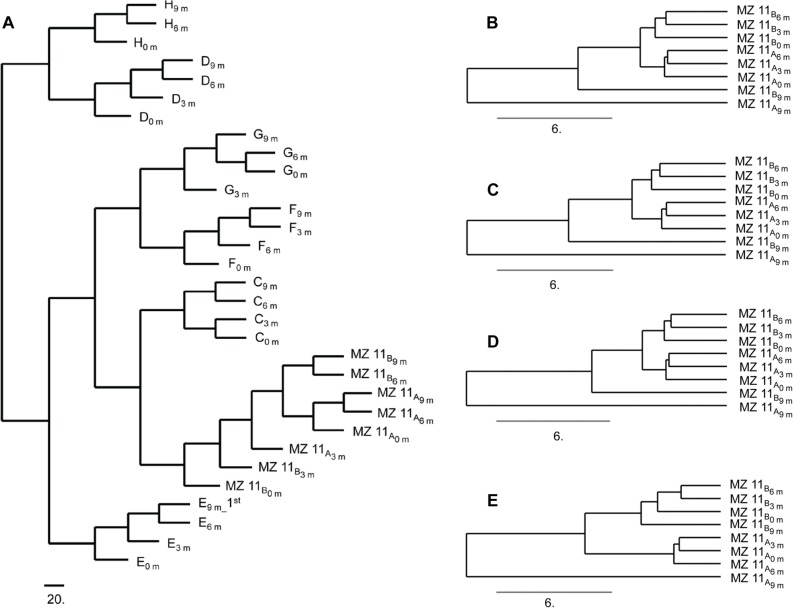
Similarity between individuals based on M-value.(A) Hierarchical clustering on 369,187 CpG sites from 31 whole blood samples collected from 8 individuals at 4 (0, 3, 6, and 9 months) or 3 (0, 6, and 9 months) time points. (B-D) Hierarchical clustering on CpG sites from 8 whole blood samples collected from MZ twin pair #11 at 0, 3, 6, and 9 months. The CpG sites satisfy |ΔM| > 1.0 and FDR-adjusted P value <0.05 within the MZ twin pair #11 with respect to sample collected at the 4th visit (MZ #11A_9m
vs. MZ #11B_9m), and located across all regions (N = 453) (B), on the CpG islands (N = 228) (C), or on the shores (N = 78) (D). (E) Hierarchical clustering on the CpG sites from 8 whole blood samples collected from MZ twin pair #11 at 0, 3, 6, and 9 months. The CpG sites satisfy|ΔM| > 1.0 and FDR-adjusted P value <0.0001 within the MZ twin pair #11 with respect to samples collected at 4th visit (MZ #11A_9m
vs. MZ #11B_9m), and located on the shores (N = 33).